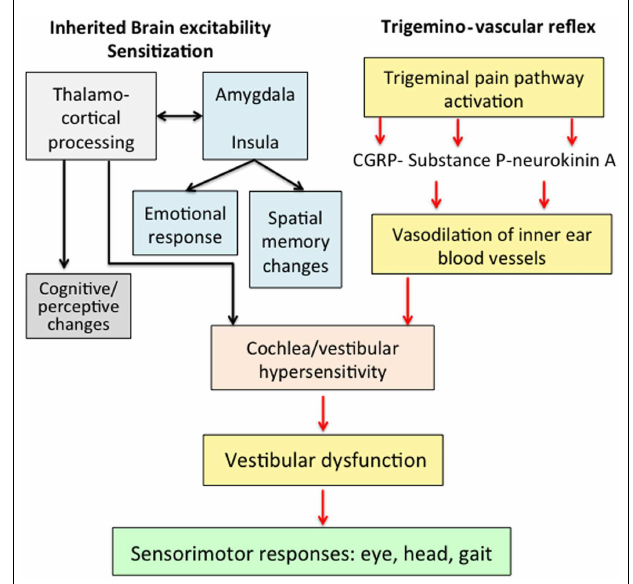
FIGURE 1 | Mechanisms involved in the pathophysiology of vestibular migraine . An abnormal brain sensitization leading to a dysmodulation of multimodal sensory integration in thalamo-cortical processing could interact with the trigemino-vascular reflex.The abnormal processing of vestibular and nociceptive information could determine a transient vestibular dysfunction associated with migraine